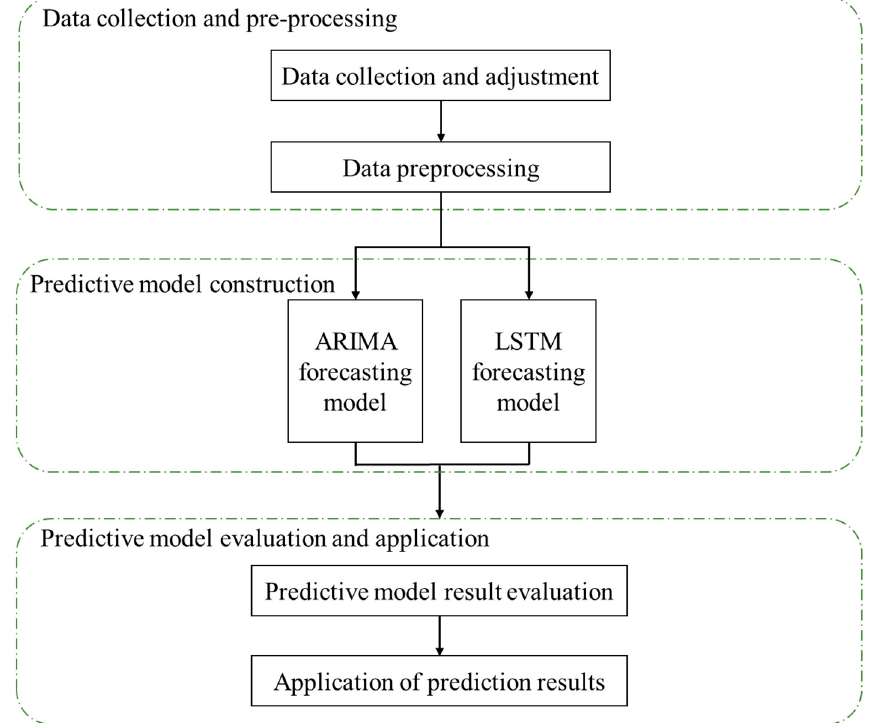
Figure 2. Research framework flow chart.